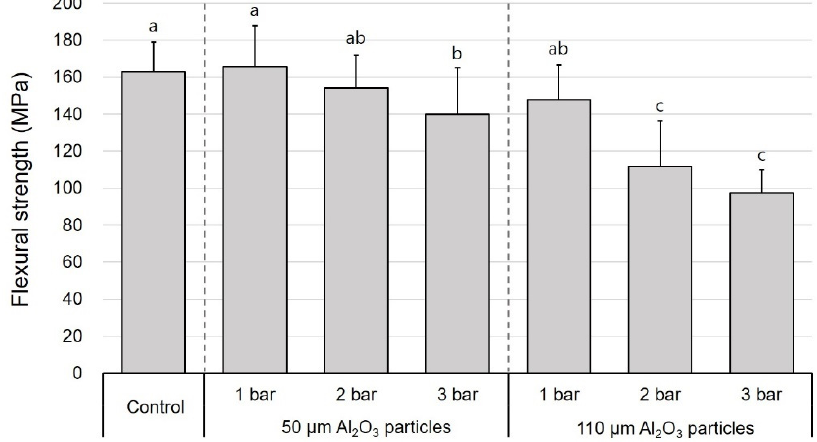
Figure 2. One-way ANOVA and post-hoc test results for the effects of the entire group of surface treatments on the flexural strength of disperse-filled composites specimens with respect to Al 2 O 3 particle size and air abrasion pressure (mean + standard deviation). Different lowercase superscript letters indicate significant differences in flexural strength.